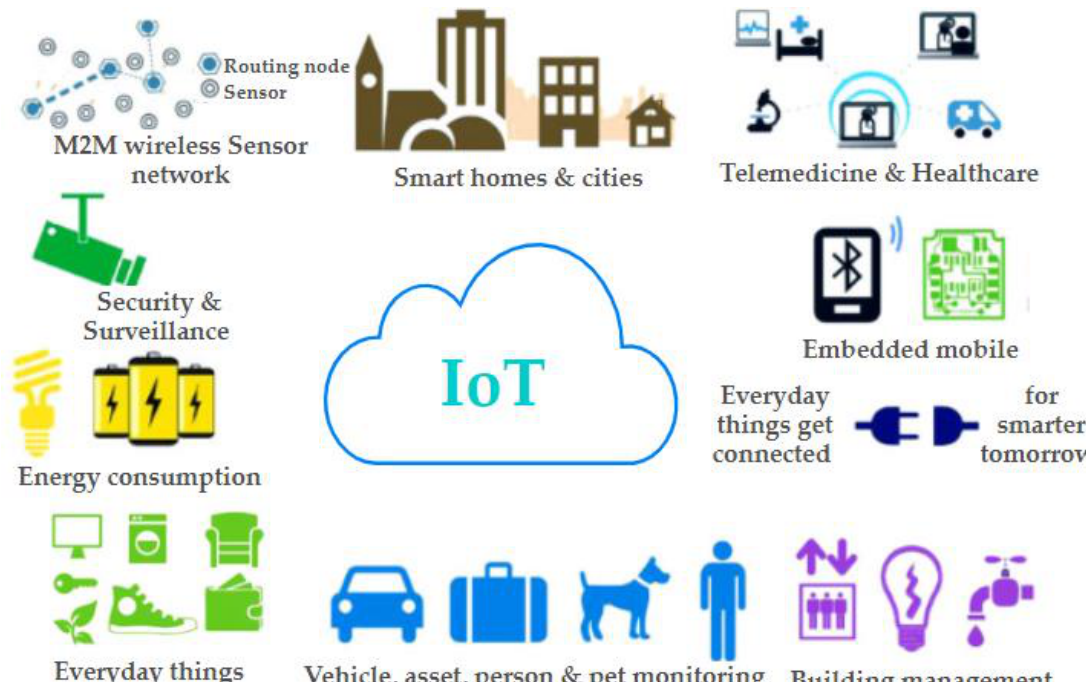
Figure 17. A summary of different components of the Internet of Things technologies platform (Note: M2M—machine 2 machine, IoT—internet of things).